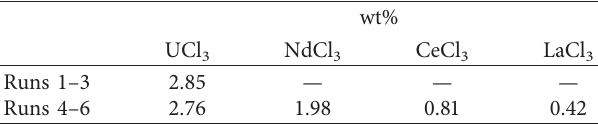
Table 1: Salt composition for each of the U/RE electrodeposition tests.